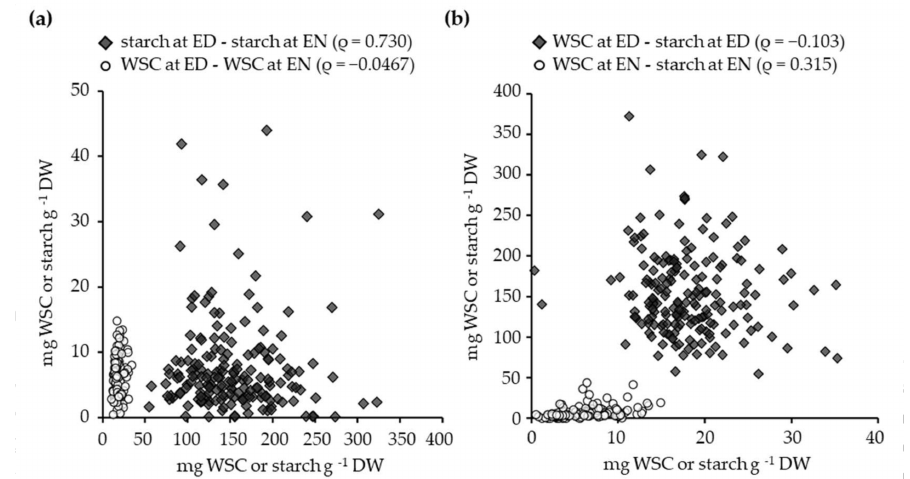
Figure 4. The relationship between combined WSC and starch contents at ED and at EN. ( a ) The relationship between WSC content at ED and EN, and the starch content at ED and EN; ( b ) the relationship between measured WSC and starch contents at EN at EN, and measured WSC and starch contents at ED. The corresponding p -values to the Spearman-rank correlation coefficients ( (cid:36) ) are indicated in the text. Measurements for glucose, fructose, sucrose, and starch content were the same as described in Figure